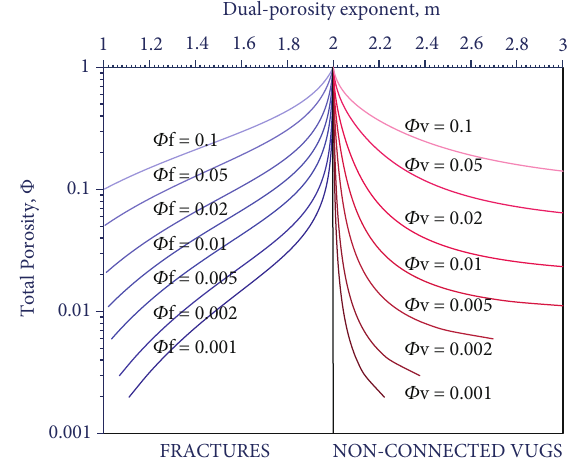
Figure 4: In fl uences of fractures [8] and nonconnected vugs [6] on the m value of the